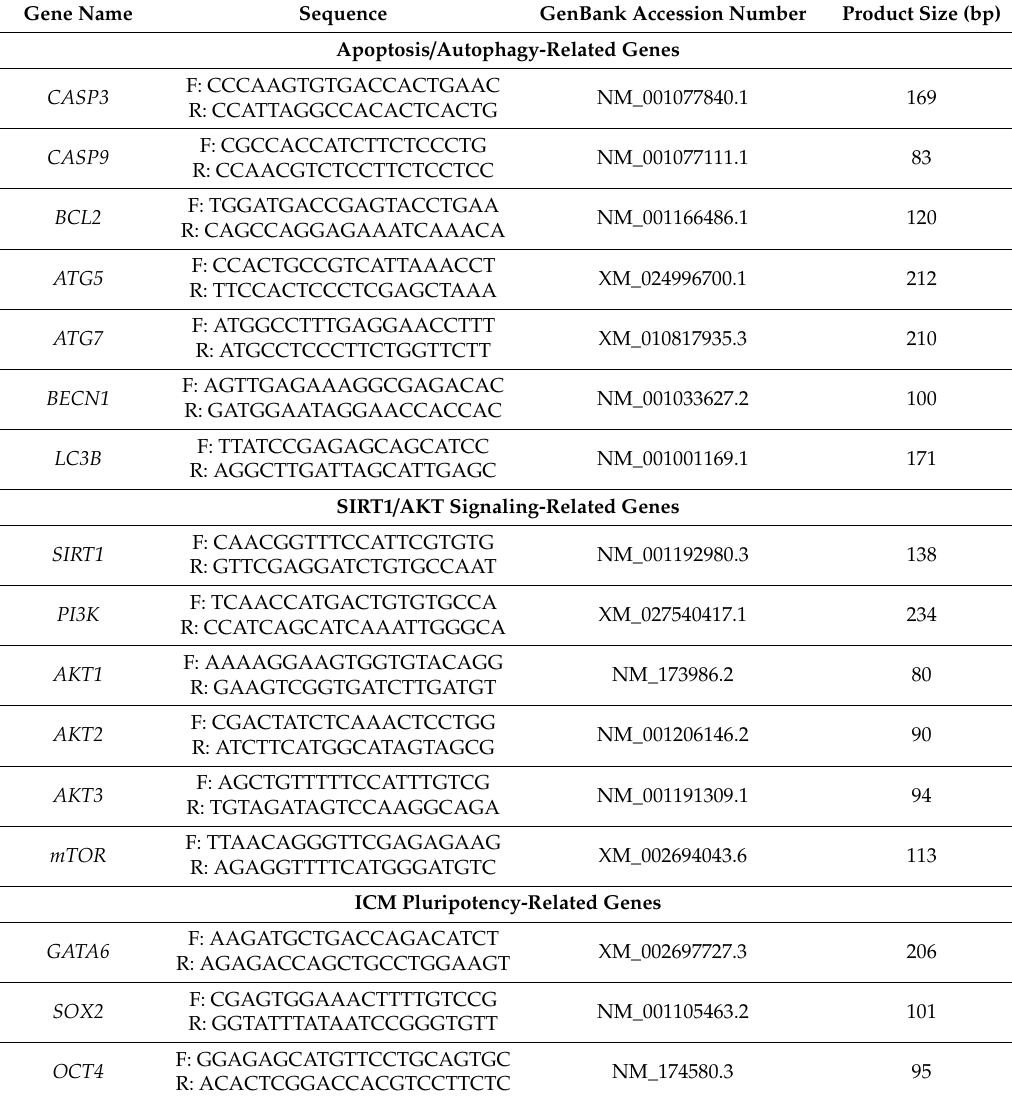
Table 1. Sequences and amplification sizes of the primers used in RT-qPCR